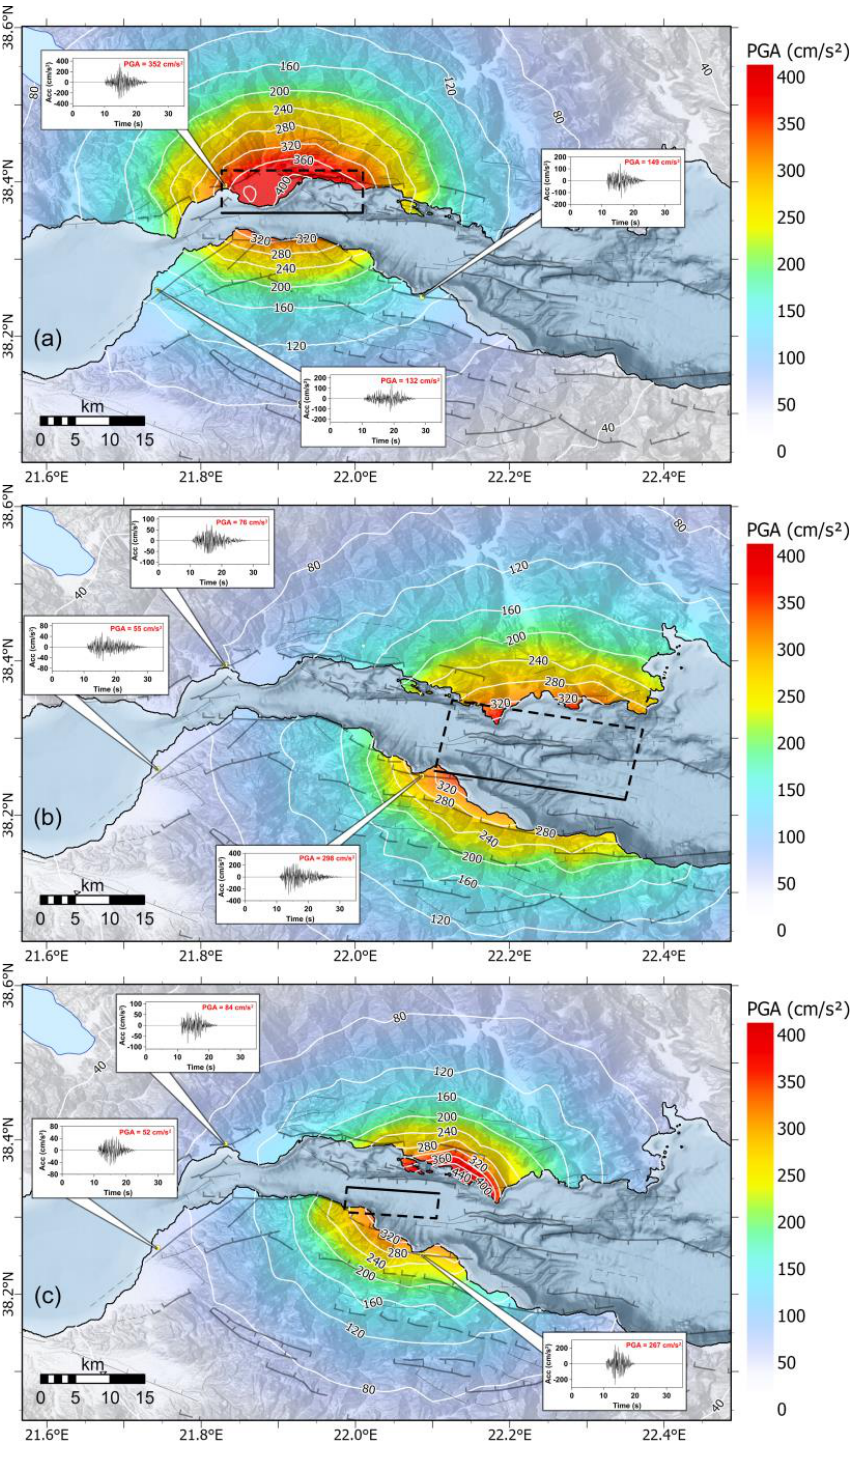
Figure 7. Spatial distribution of simulated PGA values (cm/s 2 ) calculated with the EXSIM code for the cases of the ( a ) Psathopyrgos, ( b ) Helike, and ( c ) Trizonia Faults. Synthetic acceleration time series for Patras, Nafpaktos, and Aigion are also displayed along with the maximum obtained values.